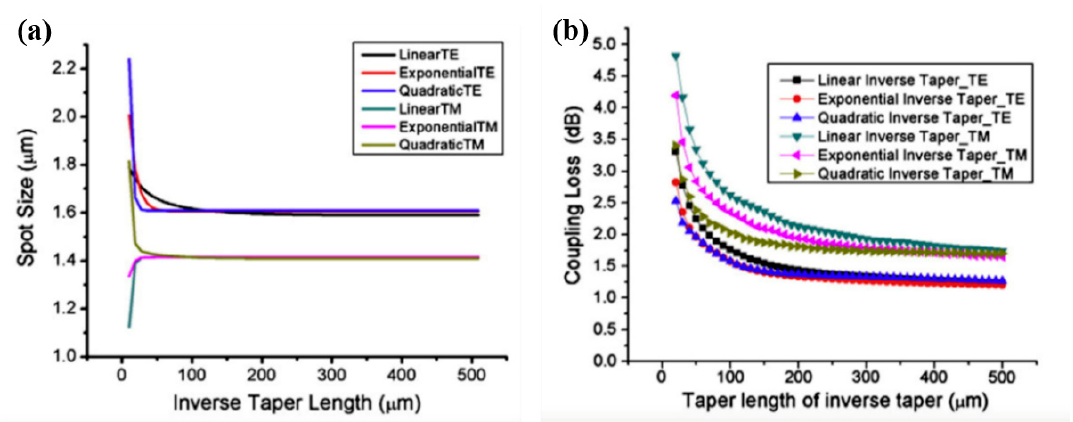
Figure 4. The relationship between inverse taper length and ( a ) spot size and ( b ) coupling loss. Reproduced with permission from [54], Copyright Elsevier, 2011.